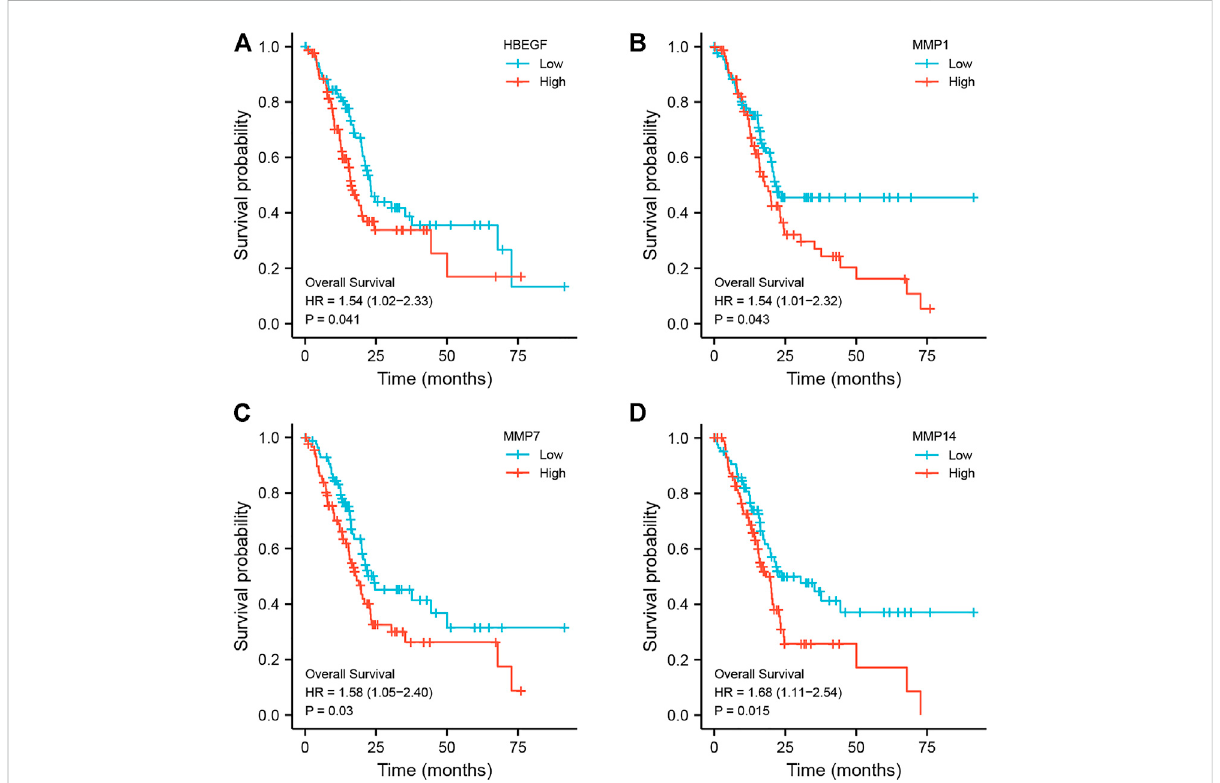
FIGURE 6 Kaplan-Meier curves of hub genes. According to the expression level of each hub gene, it is separated into high expression (red line) and low expression (blue line) groups, and the KM curve of each gene is drawn independently. (A) HBEGF; (B) MMP1; (C) MMP7; (D) MMP14.